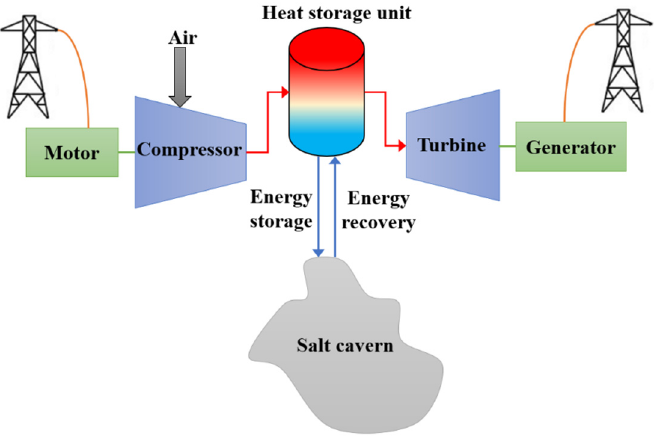
Figure 1. The layout of the considered CAES unit.